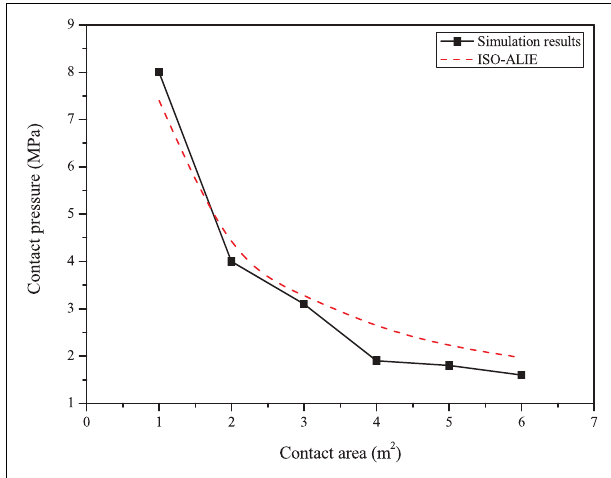
FIGURE 2 | Comparison of the simulation results with international organization for standardization (ISO) specifications for different contact areas.